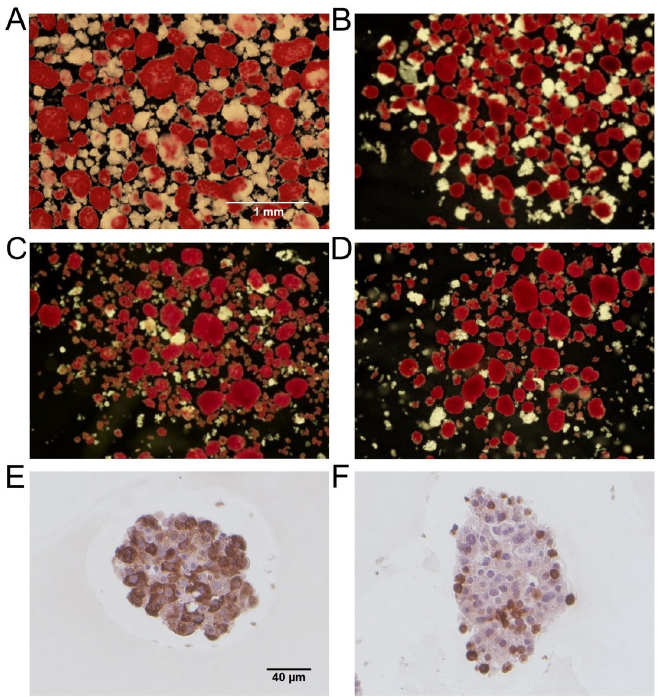
Fig 1. Representative human islet preparations. Representative dithizone-stained images of human islets used in the study with purity of 75% (A, n = 2), 80% (B, n = 3), 90% (C, n = 5), and 95% (D, n = 4). Dithizone-stained endocrine cells (red) and non-dithizone-stained exocrine cells (white) are shown. Scale bar represents 1mm. Human islets stained for insulin (E) and glucagon (F), counterstained with Harris’ hematoxylin and eosin. Scale bar represents 40 µ m.